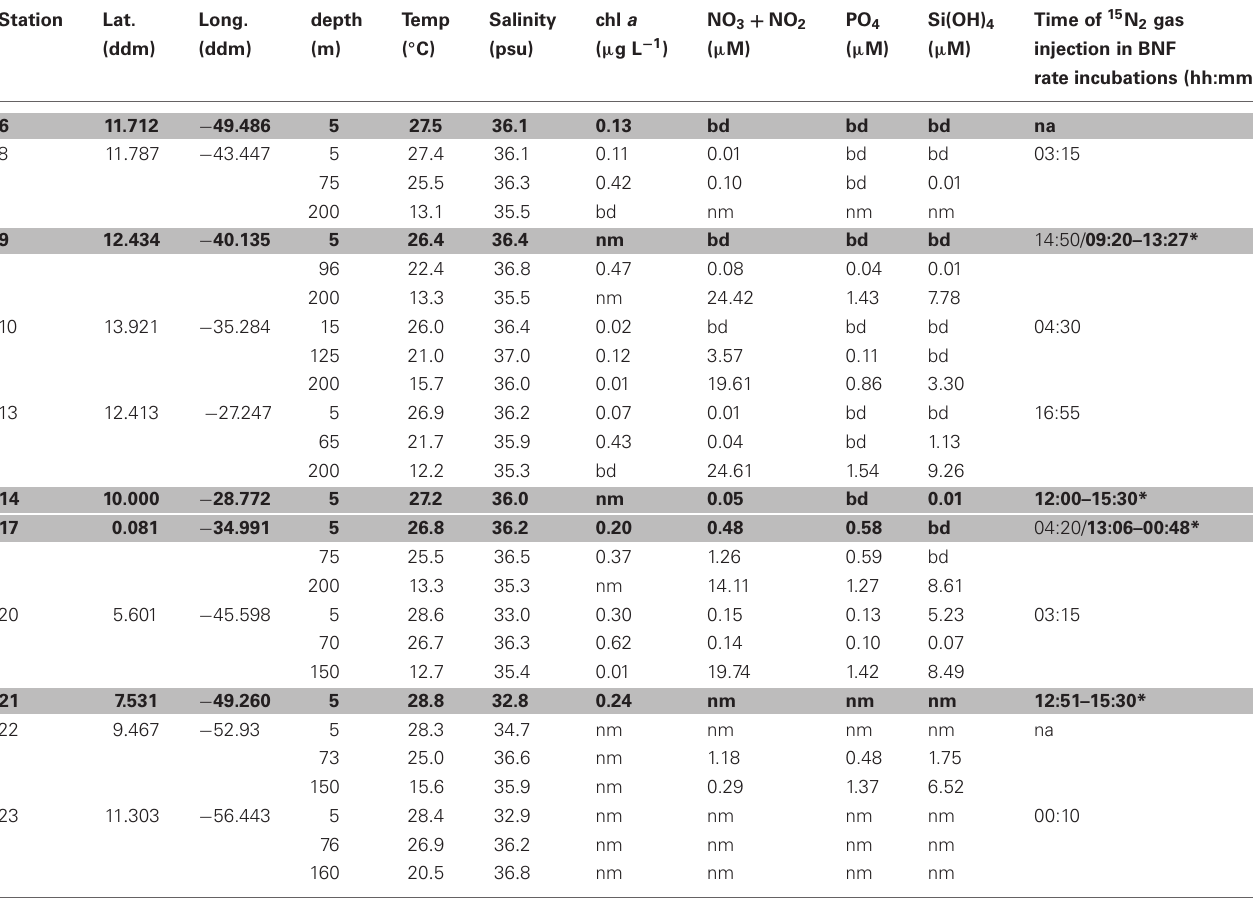
Stations where MEGA experiments were conducted are in shaded rows with bold text, and the time of 15 N 2 gas tracer injection for associated BNF